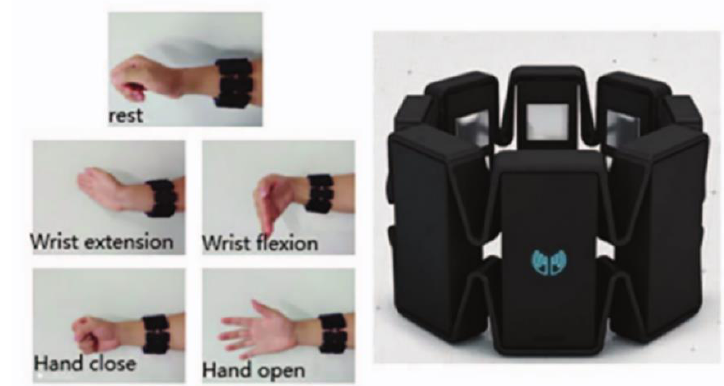
Figure 4. The 5 hand/wrist gestures and Myo armband. In this figure, the left is a schematic diagram of five gestures, and the right is the Myo armband.